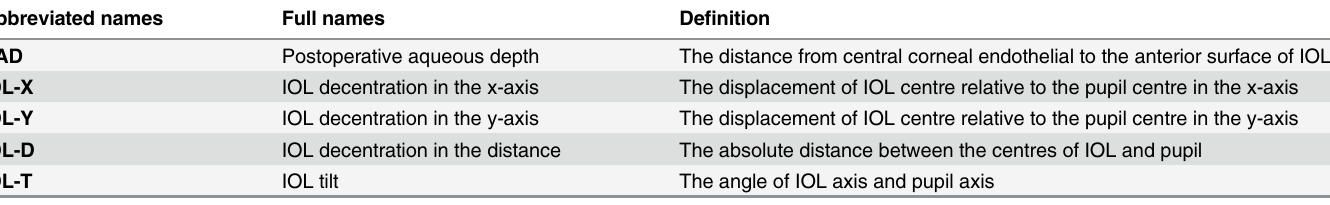
Table 2. Parameters definition of IOL position after three-dimensional (3-D) construction of anterior